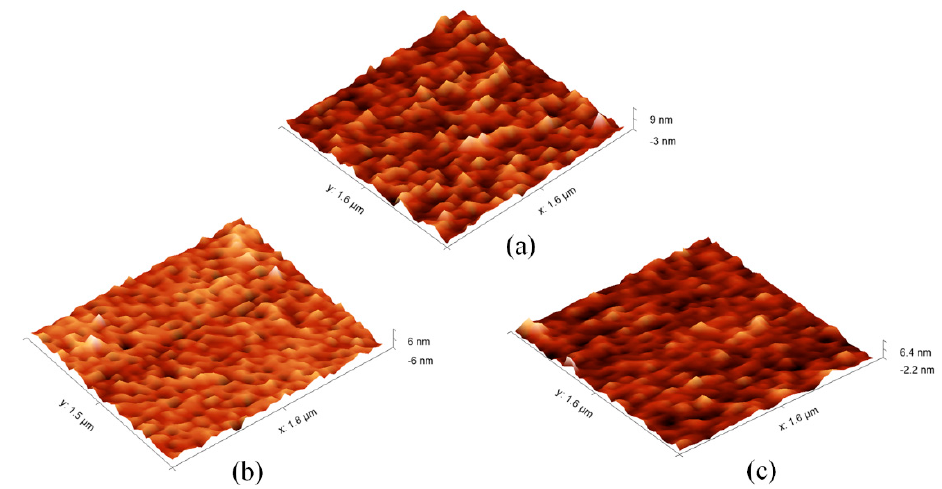
Figure 4. Contact mode 3D AFM images of: ( a ) PoAP–MEL film, ( b ) PoAP–MEL film removed template MEL and ( c ) NIP film. RMS are 1.04 nm, 0.87 nm and 0.61 nm respectively.